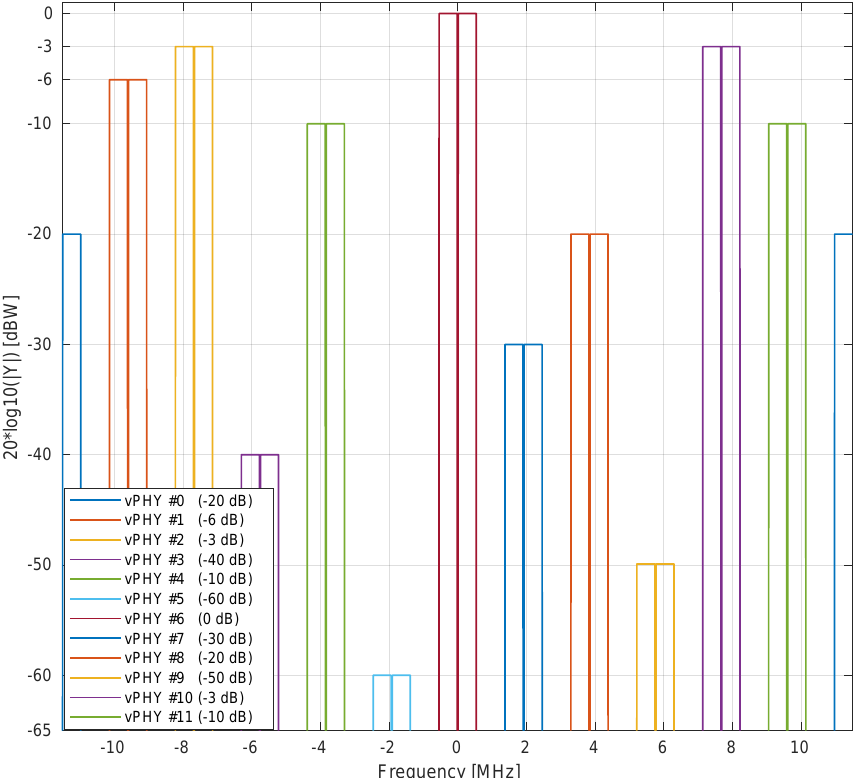
Figure 12. Frequency-domain representation of the wide baseband signal generated by the hypervisor.